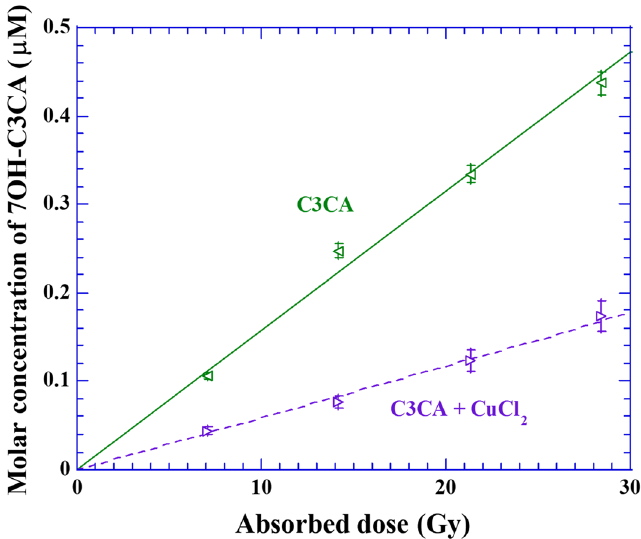
Figure 1. Molecular concentration of 7OH-C3CA formed after exposures to gamma rays from Cs-137. The leftward triangles represent the molar concentration of 7OH-C3CA formed in C3CA solution made by 1/15 M phosphate buffer and the rightward triangles show that made by ultra pure water with non-radioactive copper chloride